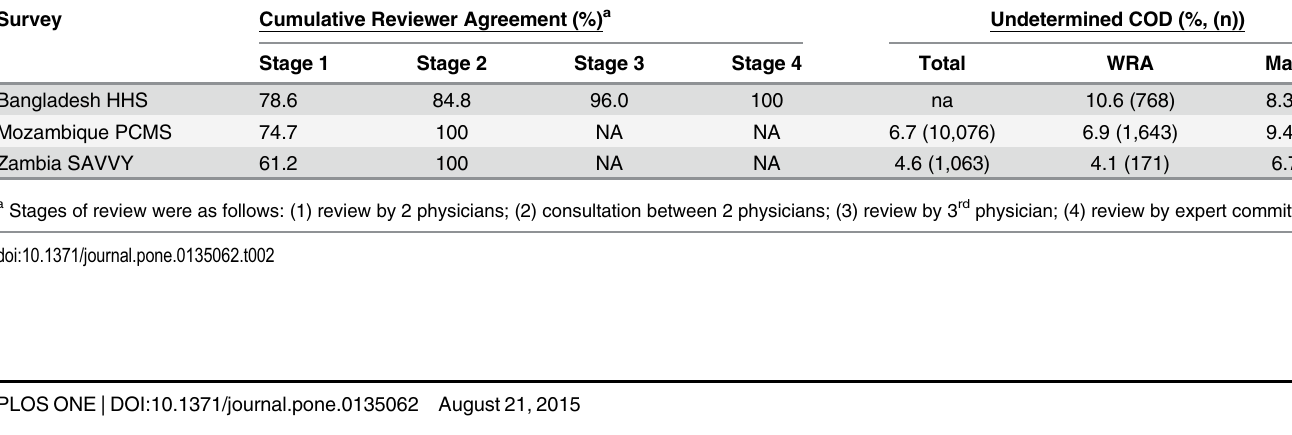
Table 2. Verbal autopsy cause of death (COD) review: percent agreement and percent undetermined cause (unweighted).